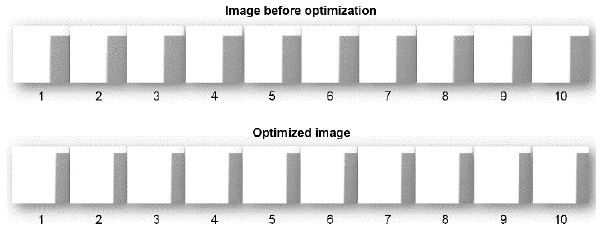
Figure 17. Ten sets of partial images before and after optimization.